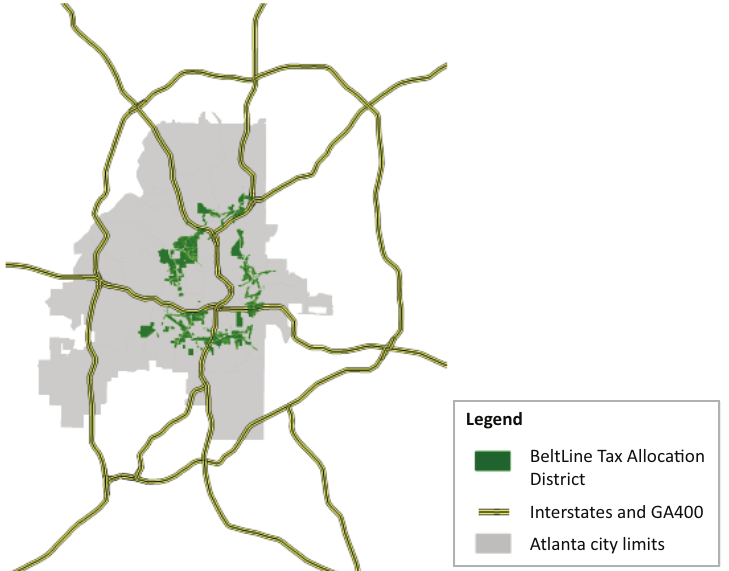
Figure 1. Map of Atlanta BeltLine